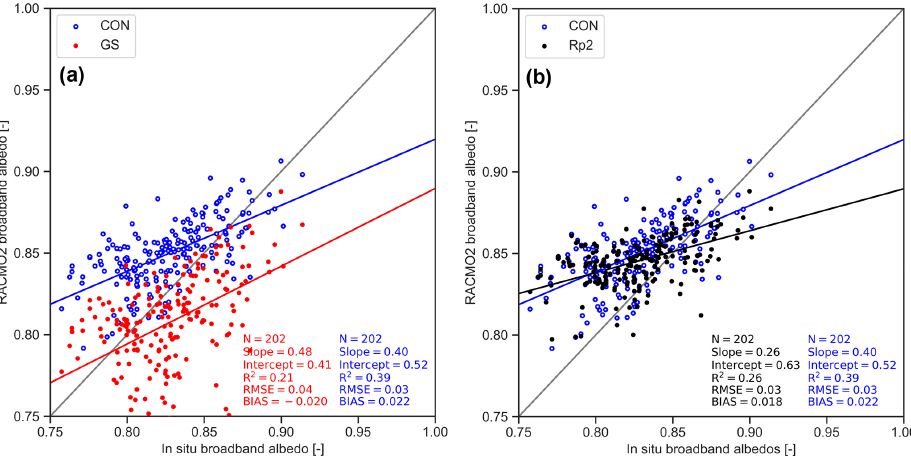
Figure 7. Monthly-averaged albedo in DML in (a) CON and GS and (b) CON and Rp2 compared to AWS measurements between 1997 and 2012. The gray lines are the one-on-one lines, and the red and blue lines are linear regression of the data, with the number of observations ( N ), the slope, the intercept, the correlation coefficient ( R 2 ), the bias and root-mean-square error (RMSE).